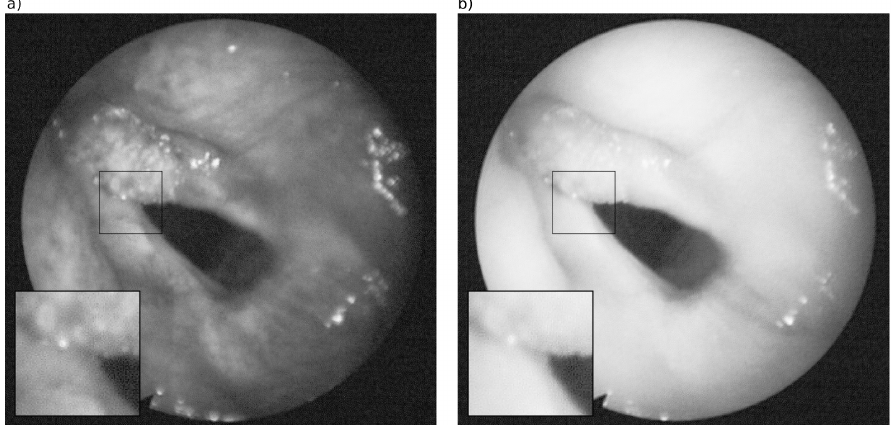
Figure 6. HS images of the larynx (#caseA) after removing the honeycomb-like pattern by our method at wavelength ( a ) 510 nm and ( b ) 610 nm (corresponding to the images in Figure 1).